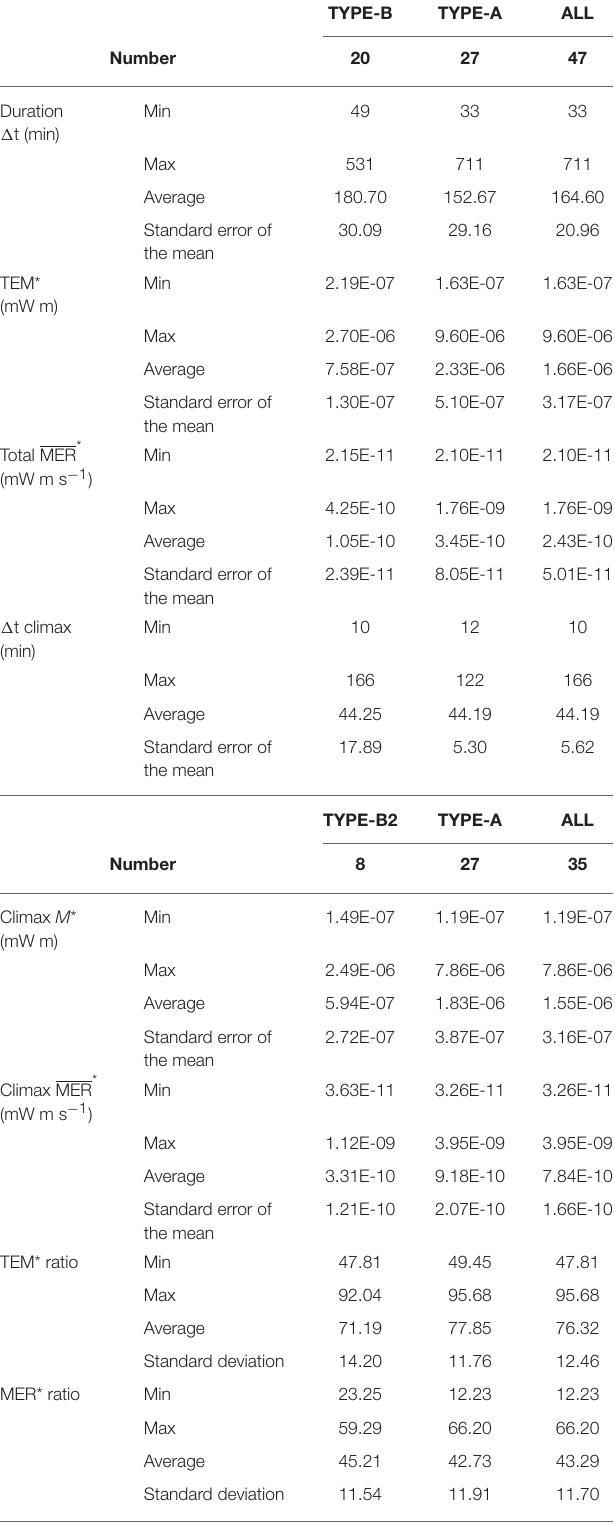
TABLE 1 | Statistical values of the retrieved mass proxies of Mount Etna paroxysmal activity recorded by VOLDORAD